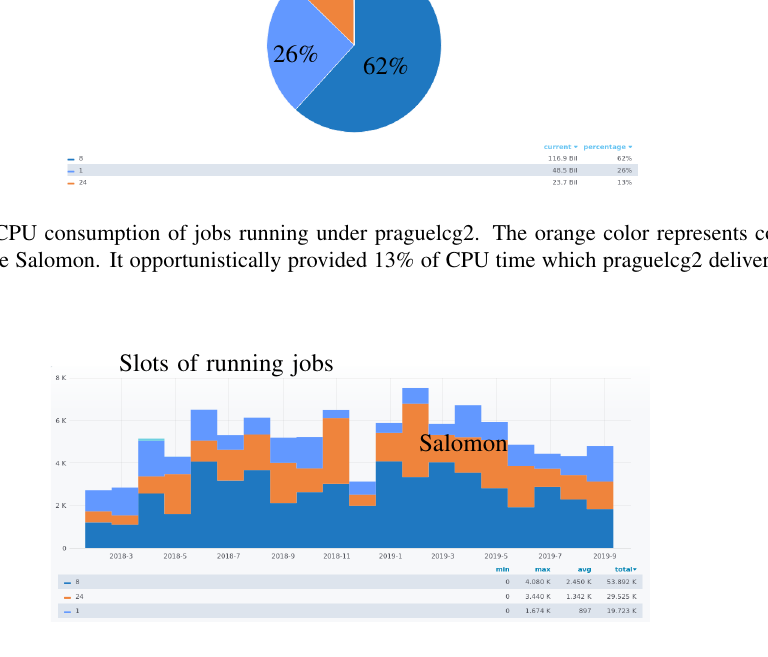
Figure 8. Slots of running jobs of the praguelcg2. The orange color represents contribution of the Salomon. It is fluctuating due to its opportunistic nature but the contribution is